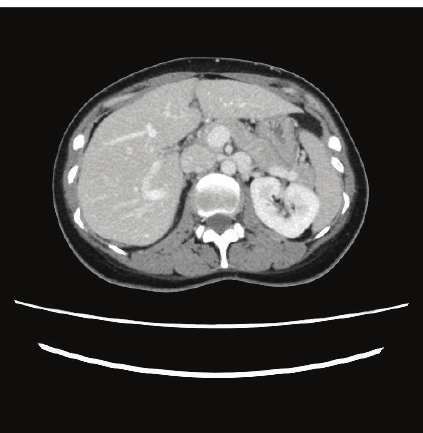
Figure 2: Enhanced computed tomography of sagittal section. The angle between the aorta and the SMA was 27.2